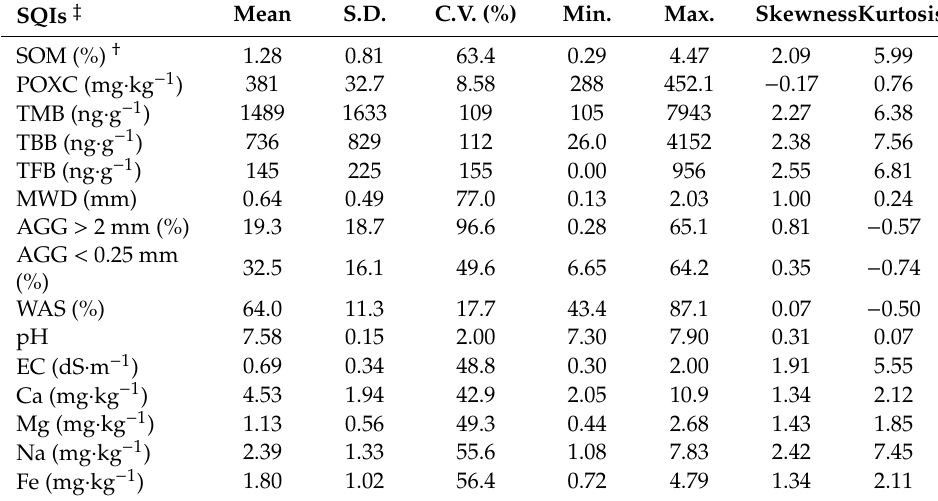
Table 5. Descriptive Statistics for laboratory-measured soil quality indicators (SQIs) using a dataset from NMSU Agricultural Science Center in Los Lunas, NM (n = 36).